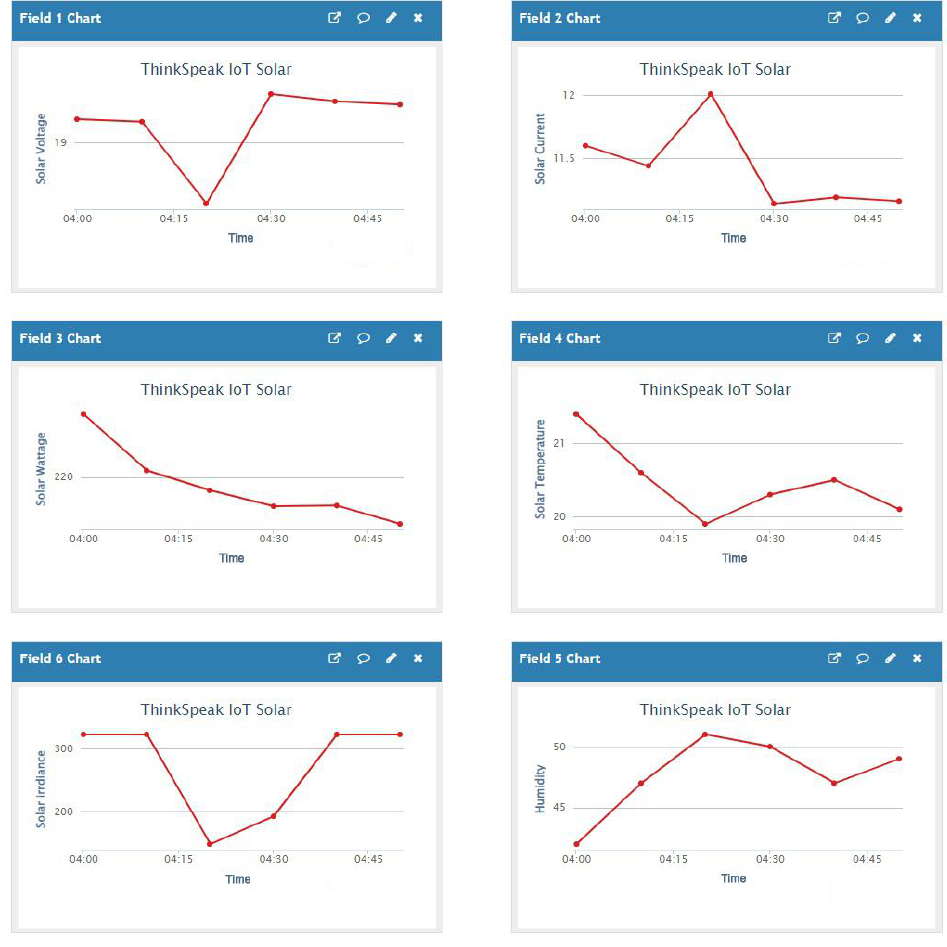
Figure 7. Real-time results for five active modules.